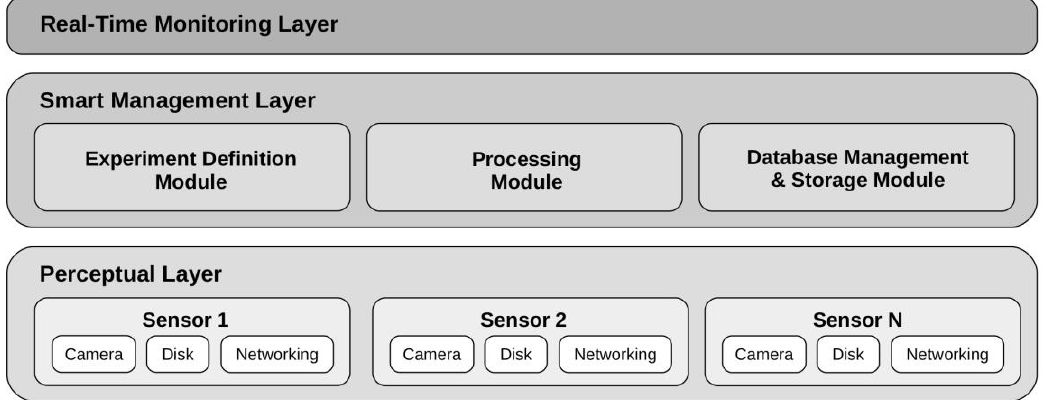
Figure 2. Multi-layer architecture for the deployment of low-cost sensor networks for automatic license plate